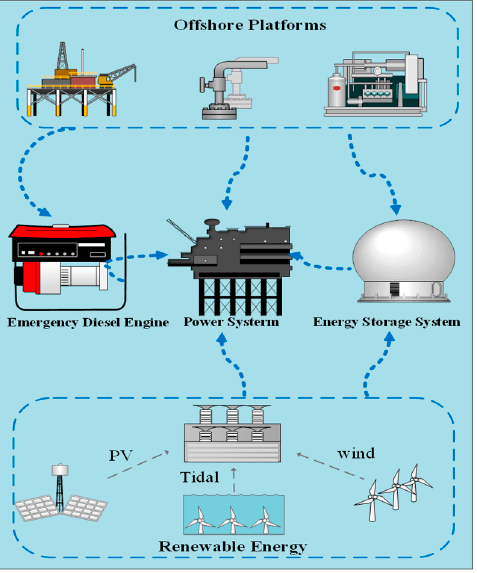
Figure 1. Structure diagram of the offshore microgrid.